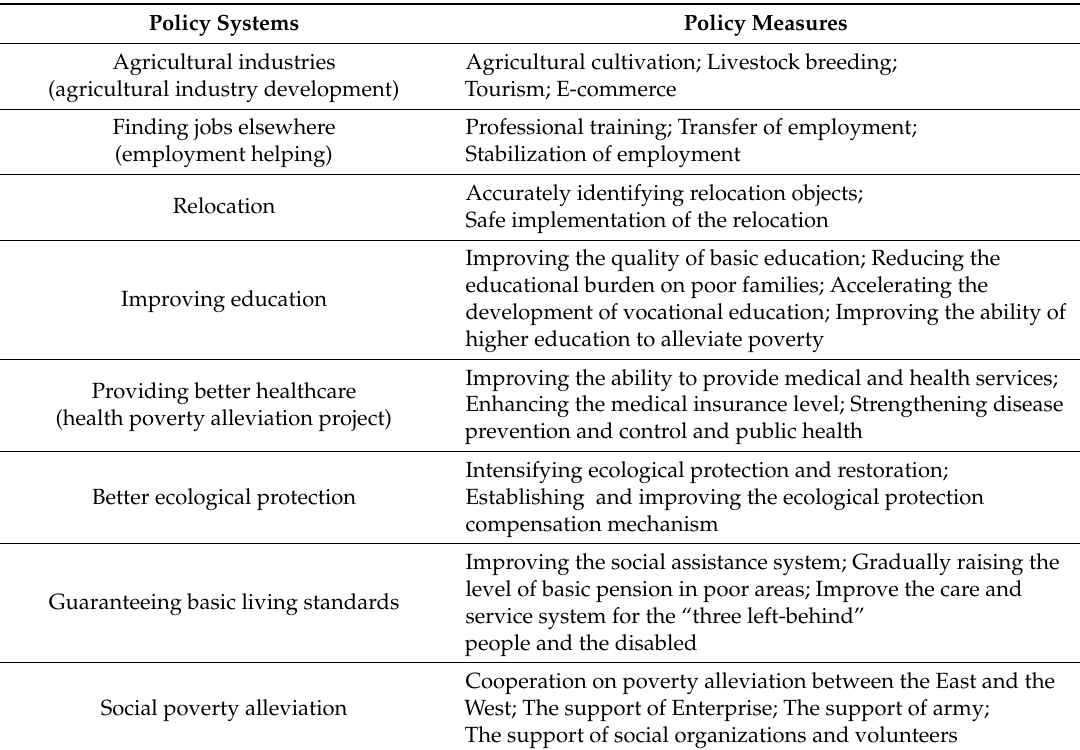
Table 1. Main policy systems and measures of poverty alleviation policy in the 13th five-year